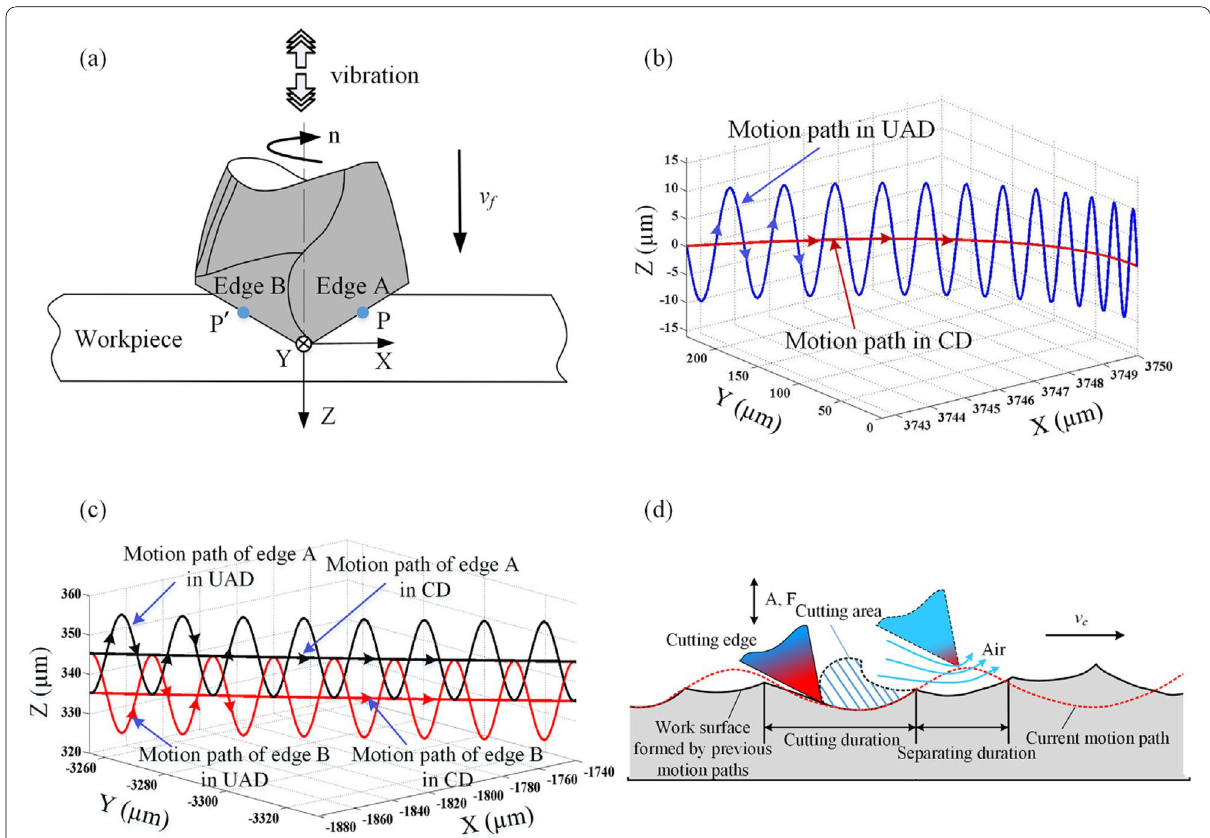
Figure 23 Different tool paths: a UAD process, b Moving locus of cutting edge for UAD and CD, c Moving locus of Edge A and Edge B for both UAD and CD, d The intermittent cutting mode in UAD